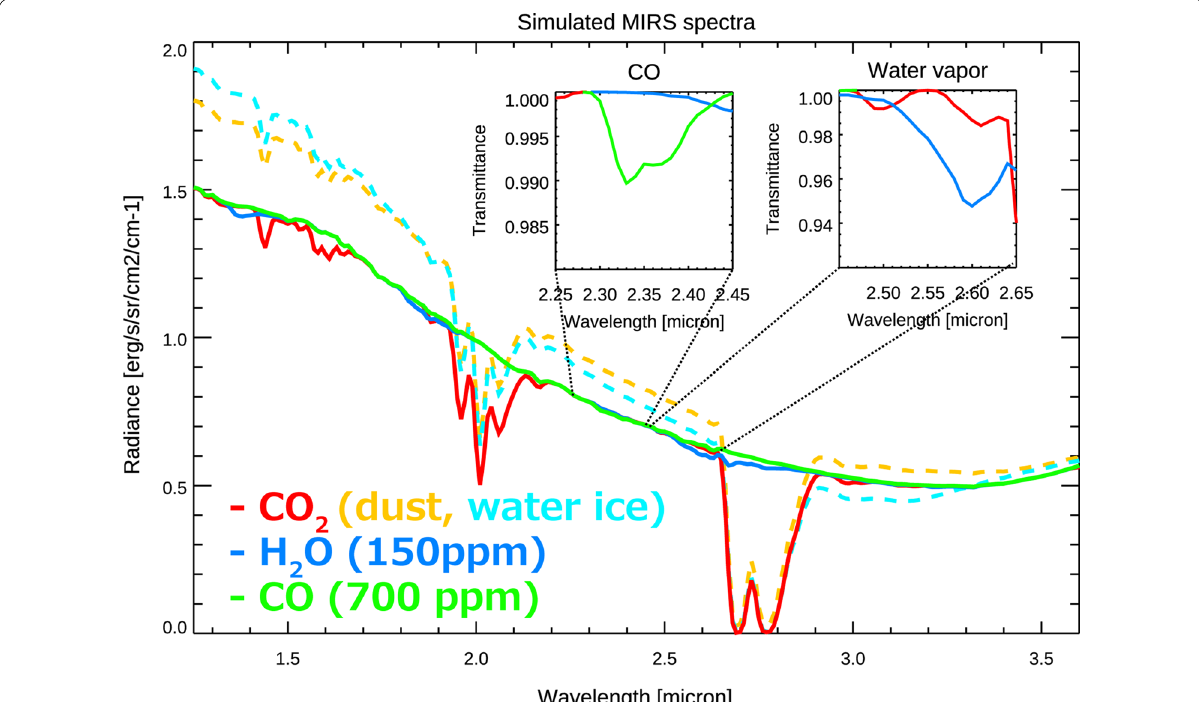
Fig. 3 Expected features of the Mars atmosphere observed by MIRS. The synthetic spectra are calculated by the widely used DISORT‑based radiative transfer model for Mars (Ignatiev et al. 2005). A typical condition of Mars atmosphere is assumed. The surface albedo of Mars is assumed to be 0.15 (uniform). The thick curves in the figure show the spectra for the clear sky condition, and the dashed curves include the effects of dust or water ice clouds. For gases, CO 2 , CO, and water vapor are calculated separately (red, orange, and blue curves, respectively). The calculated synthetic spectra are convolved with the instrumental line shape of MIRS that is a Gaussian function whose FWHM is 20 nm. The sampling step is 10